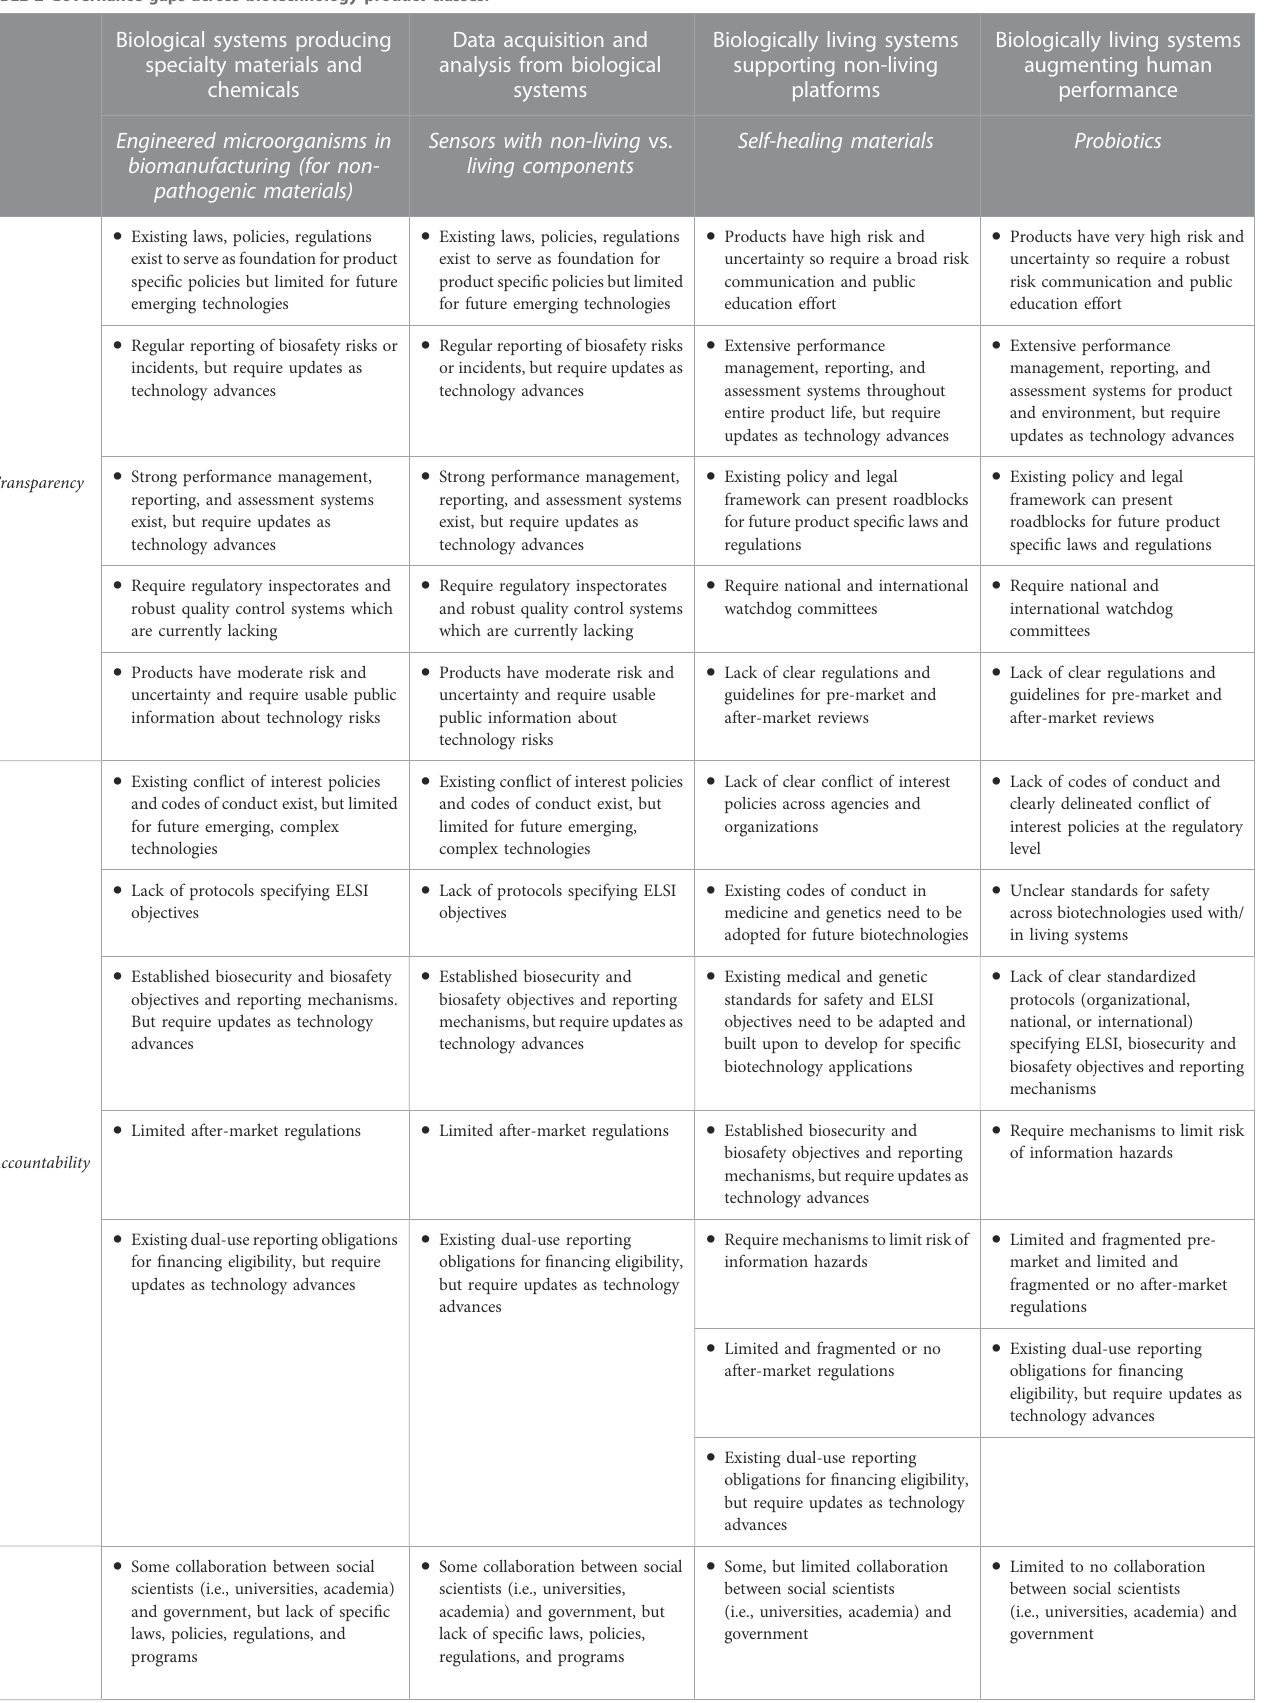
TABLE 2 Governance gaps across biotechnology product